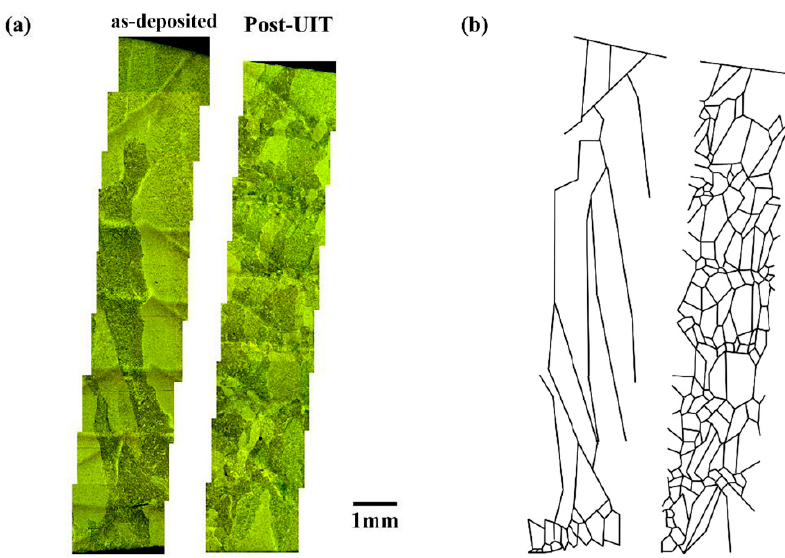
Figure 5. The macrostructure of the seven-layer sample from top layer to the interface of substrate which is perpendicular to the scanning direction: ( a ) the optical microscopy images ( b ) the grain morphology drawn from the OM images.